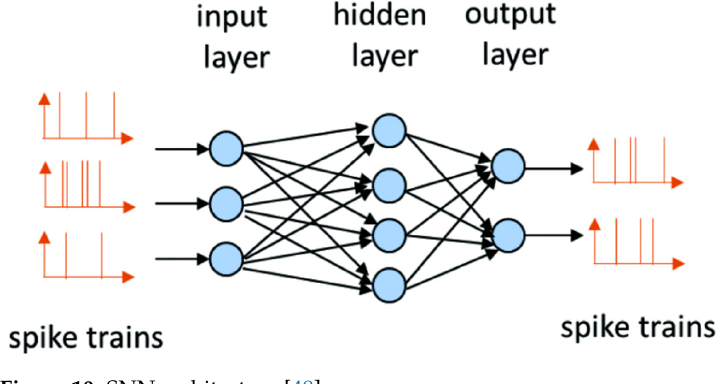
Figure 10. SNN architecture [48]. Table 6. Exemplar acoustic image representation and classifier models.